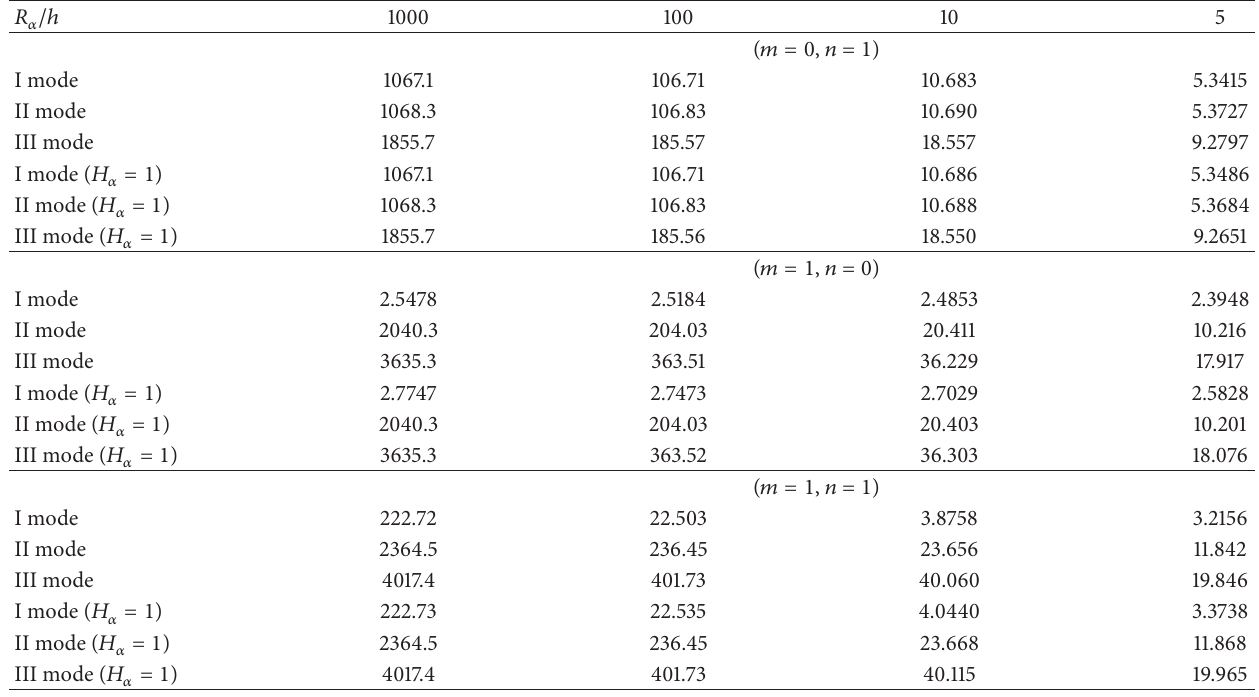
Table 15: Effects of 𝐻 𝛼 = (1 + 𝑧/𝑅 𝛼 ) terms in benchmark 5 for simply supported isotropic cylindrical shell panel. First three vibration modes in terms of no-dimensional circular frequency 𝜔 = 𝜔(𝑎 2 /ℎ)√𝜌/𝐸 for several combinations of half-wave numbers 𝑚 and 𝑛 . 𝑀 = 100 fictitious layers and 𝑁 = 3 order of expansion for the exponential matrix.